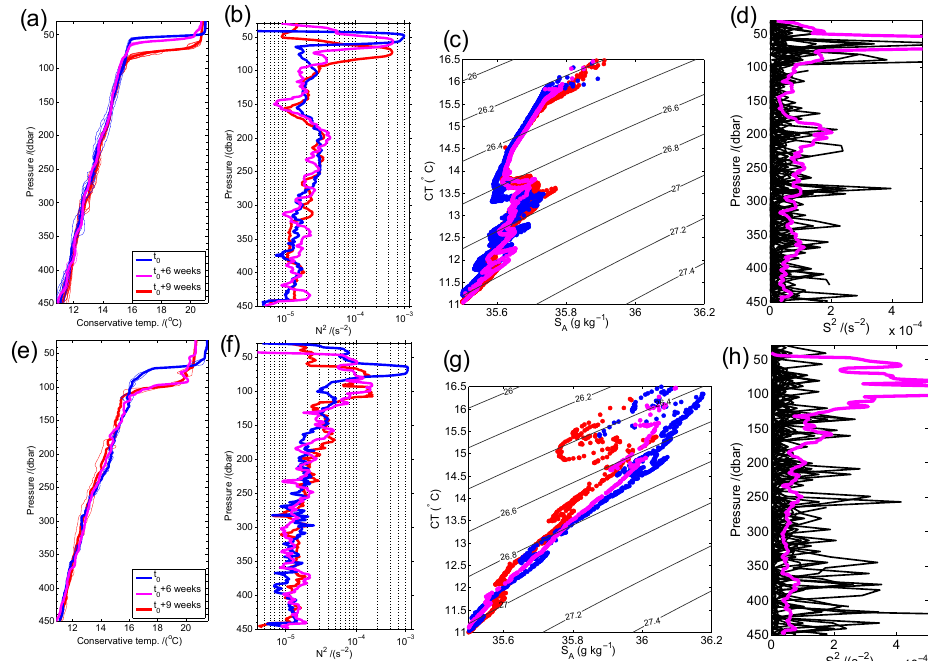
Figure 4. Eddy centre profiles for (a) (cid:50) and (b) buoyancy frequency N 2 , the (c) (cid:50)/S A diagram, and (d) vertical shear of horizontal velocities ( S ) squared. (e–h) as (a–d) but for selected profiles at the edge of the eddy. In (d, h) the magenta line indicates the magnitude of S 2 required to overcome the local stability (4 · N 2